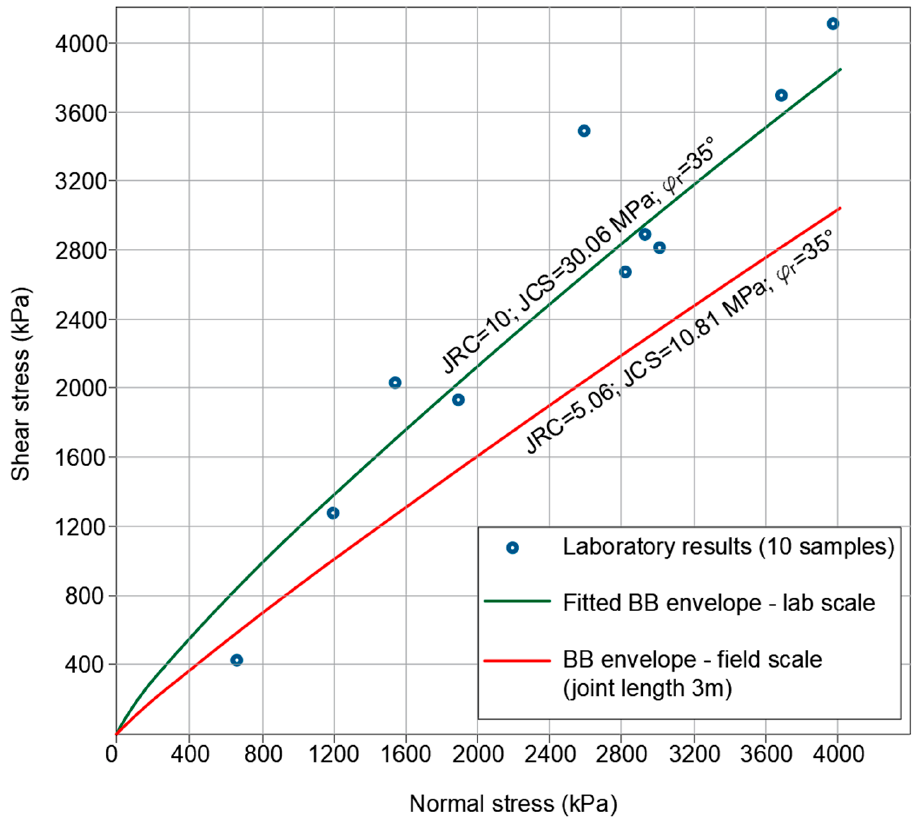
Figure 6. Envelope of BB failure criterion at discontinuities at laboratory scale (green line) and field scale block of rock mass with side lengths of 3–5 m (red line).